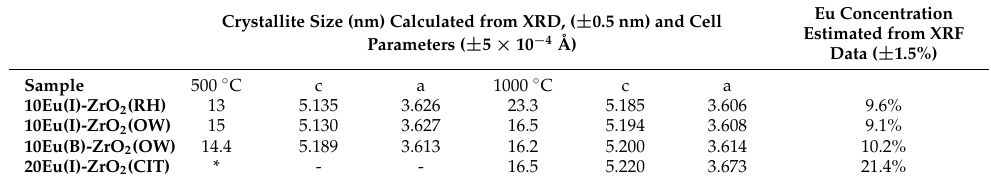
Figure 1. ( a ) Elemental chemical analysis using EDS (10Eu–ZrO 2 (OW)). The C and Cu peaks were present due to the copper grid provided with a carbon membrane; ( b ) XRF spectra of 10Eu(B)–ZrO 2 (OW), 10Eu(I)–ZrO 2 (OW), 10Eu(I)–ZrO 2 (RH) and 20Eu(I)–ZrO 2 (CIT); ( c ) XRD patterns, annealing temperatures of 500 and 1000 ◦ C; and ( d ) selected Raman spectra, annealing temperature of 1000 ◦ C. Table 1. Crystallite size and cell parameters of 10Eu(I)–ZrO 2 (OW, RH) and 20Eu(I)–ZrO 2 (CIT) following annealing at 500 and 1000 ◦ C. Bare ZrO 2 nanoparticles were amorphous prior to annealing, irrespective of the synthetic